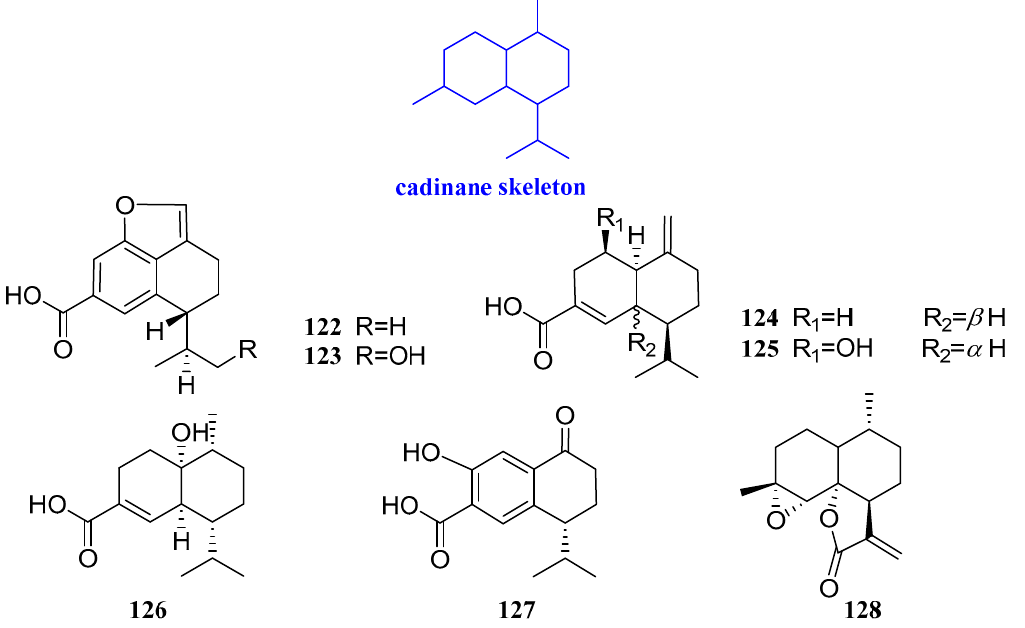
Figure 10. Structures of cadinane-type sesquiterpenoids 122 − 128